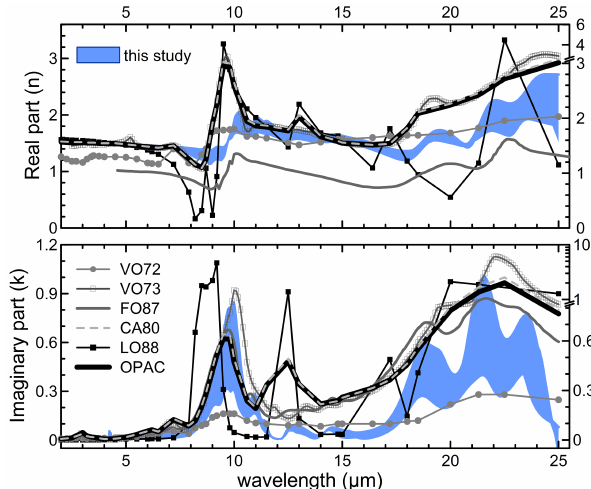
Figure 7. Comparison of our results with other direct and indirect estimates of the dust refractive index as reported in the literature. The plot reports the real and the imaginary parts of the refractive index for (1) Volz (1972) (indicated as VO72 in the plot): rainout dust aerosols collected in Germany and composed of a mixture of soil particles, fly ashes, and pollen (spectroscopy method; also used as the “dust-like” model in Shettle and Fenn, 1979). (2) Volz (1973) (indicated as VO73): Saharan dust collected at Barbados, West In- dies (spectroscopy method). (3) Fouquart et al. (1987) (indicated as FO87): Saharan sand collected at Niamey, Niger (spectroscopy method). (4) Carlson and Benjamin (1980), Sokolik et al. (1993) (indicated as CA80): mineral dust model, as used in the OPAC and GADS databases (based on a synthesis of measurements on Saha- ran dust or generally on desert aerosols). (5) Longtin et al. (1988) (indicated as LO88): dust sand, i.e. modelled as an internal mixture of hematite (10% by volume) and quartz. In the internal mixing hy- pothesis the dust refractive index is calculated as the volume aver- age of the refractive indices of individual minerals. (6) OPAC desert model: modelled as an internal mixture of a water soluble compo- nent at 80% relative humidity (5% by volume), and mineral dust in nucleation (3% by volume), accumulation (72% by volume) and coarse (20% by volume) modes (Hess et al., 1998); the dust refrac- tive index for the three modes is that reported by CA80. The region in blue in the plot indicates the range of variability of the results of this study. The legend in the bottom panel identifies the line styles used in the plot for literature data. Refractive index y axes are lo- cated on the left side of the plots, with the only exception of LO88 for which the y axis is on the right